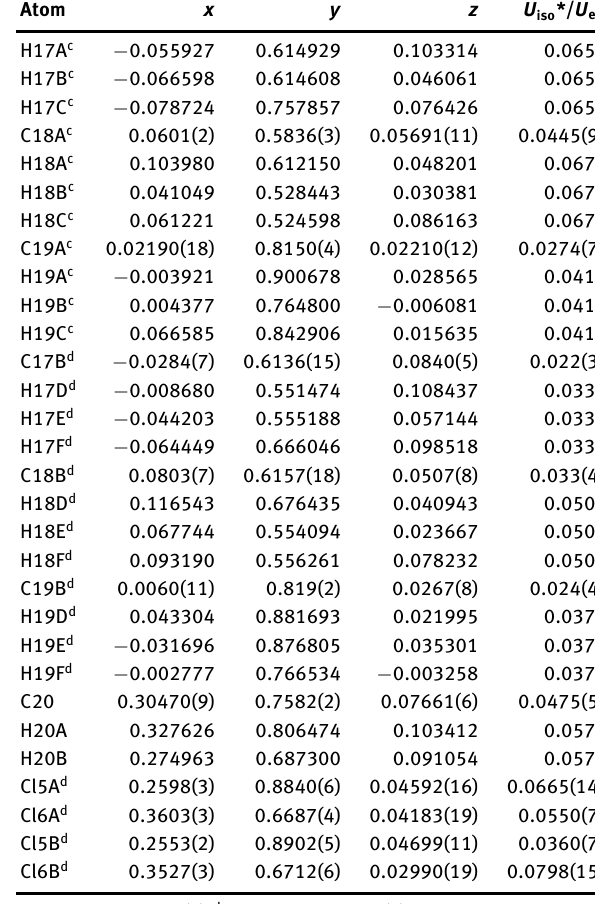
between 2.2716(5) and 2.2888(5) Å and Cl—Co—Cl bond angles ranging from 105.98(2) to 113.52(2)°. These bond parameters around the metal centre are comparable to those of similar compounds in literature [6–9]. The 1,1′-methylenebis(4- tert -butylpyridinium) cation has a V-shape conformation, which is defined by the bridging –CH 2 – group. Furthermore, the dihedral angle between the two pyridinium rings was found to be 67.9°. Intermolec-